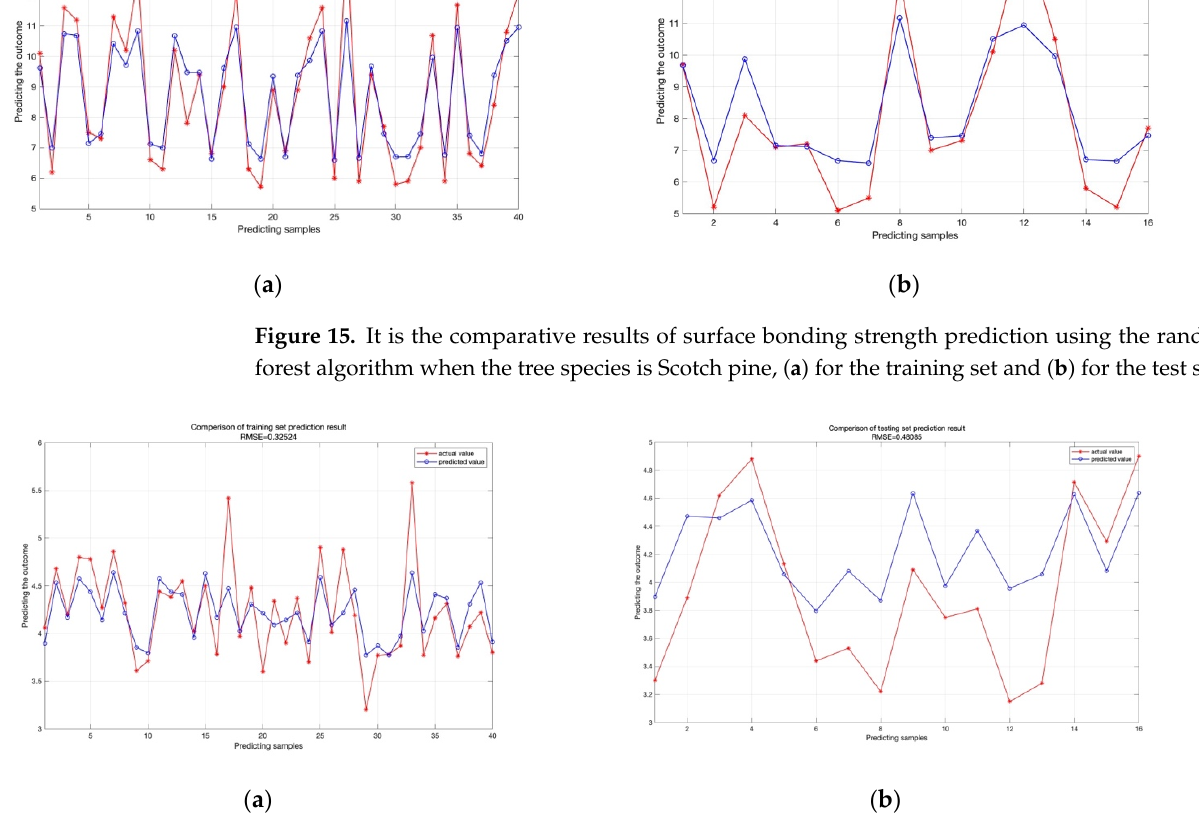
Figure 16. It is the comparative results of surface roughness prediction using the random forest algorithm when the tree species is Scotch pine (Ra) , (a) for the training set and (b) for the test set.